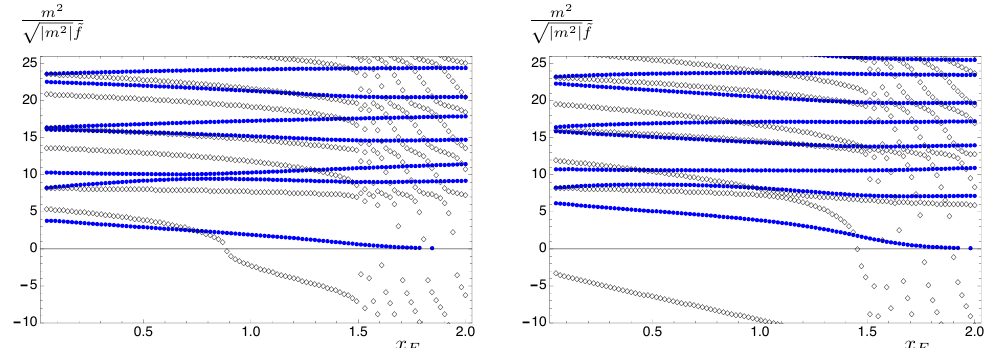
Figure 17 . Model IIA (left) and IIB (right). Spectrum of scalar resonances (blue) compared to the probe approximation (black diamonds) as a function of x ρ 2 = 8 , and φ A = 2 (Model IIA, left), φ B = 0 . 9 (Model IIB, right), normalized to the decay constant √ ˜ f ≡ f/ N C